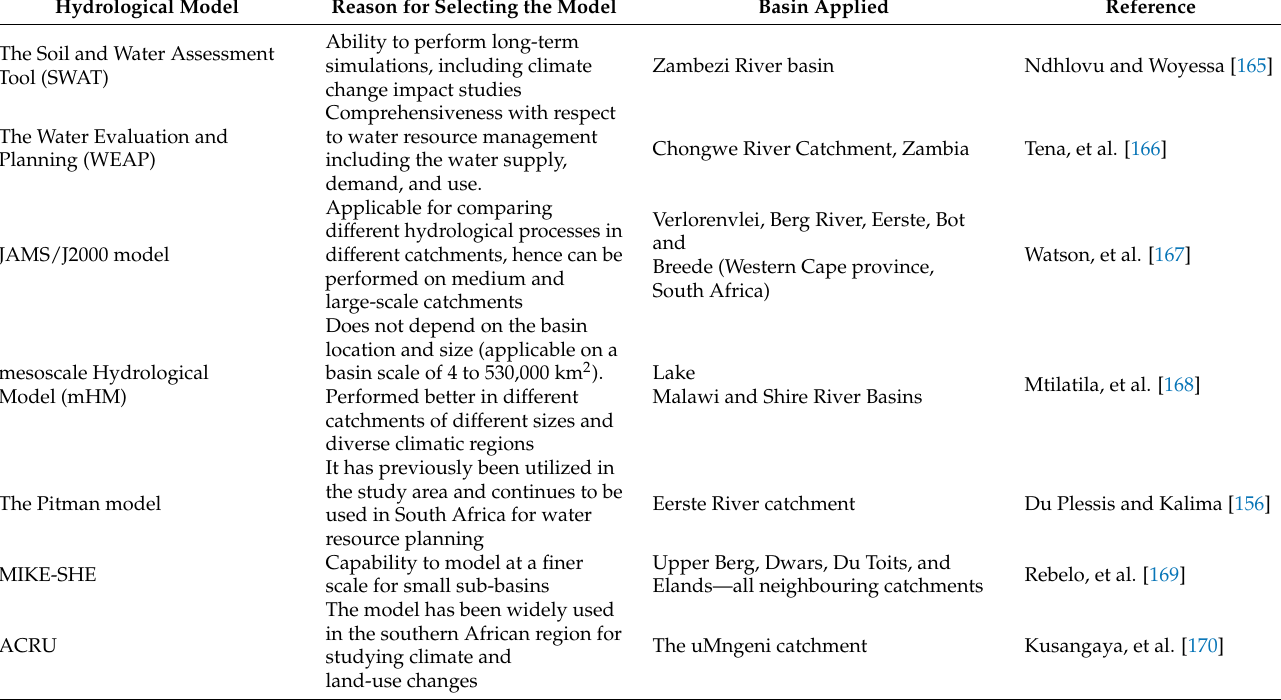
Table 2. Summary of some of the recent studies in southern Africa applying hydrological